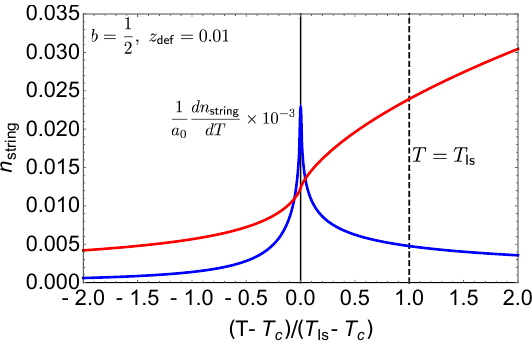
string , in the vicinity of the critical point, calculated from